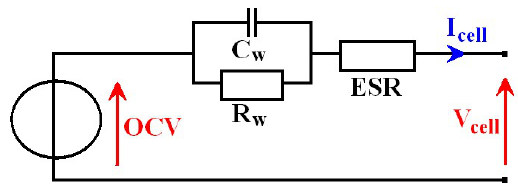
Figure 1. Cell second order Thevenin model.